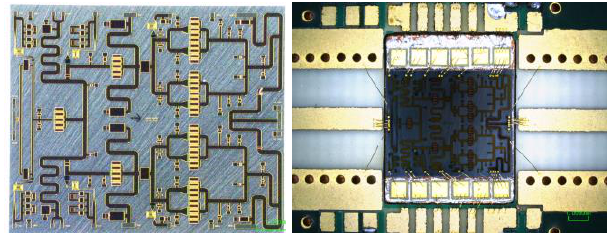
Figure 9: Manufactured PA MMIC at 8-10 GHz and placement on the PCB